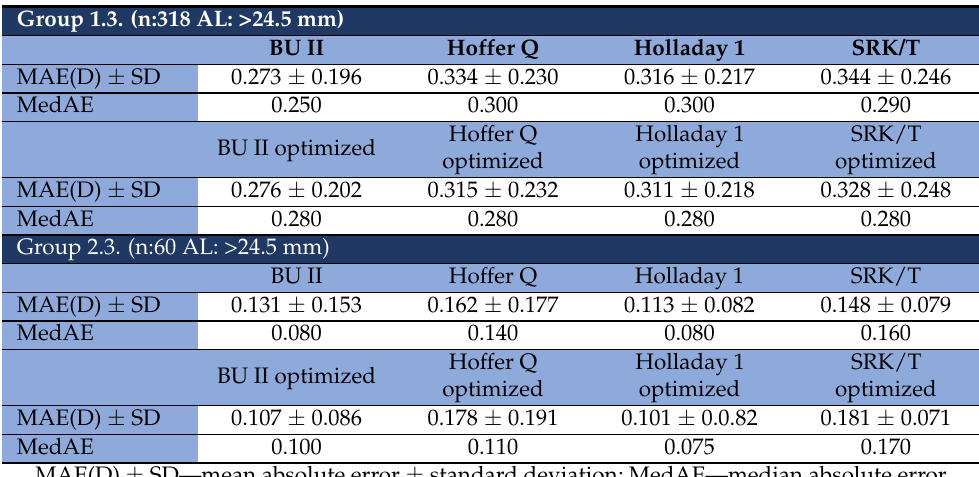
Table 9. Prediction errors for groups with AL > 24.5